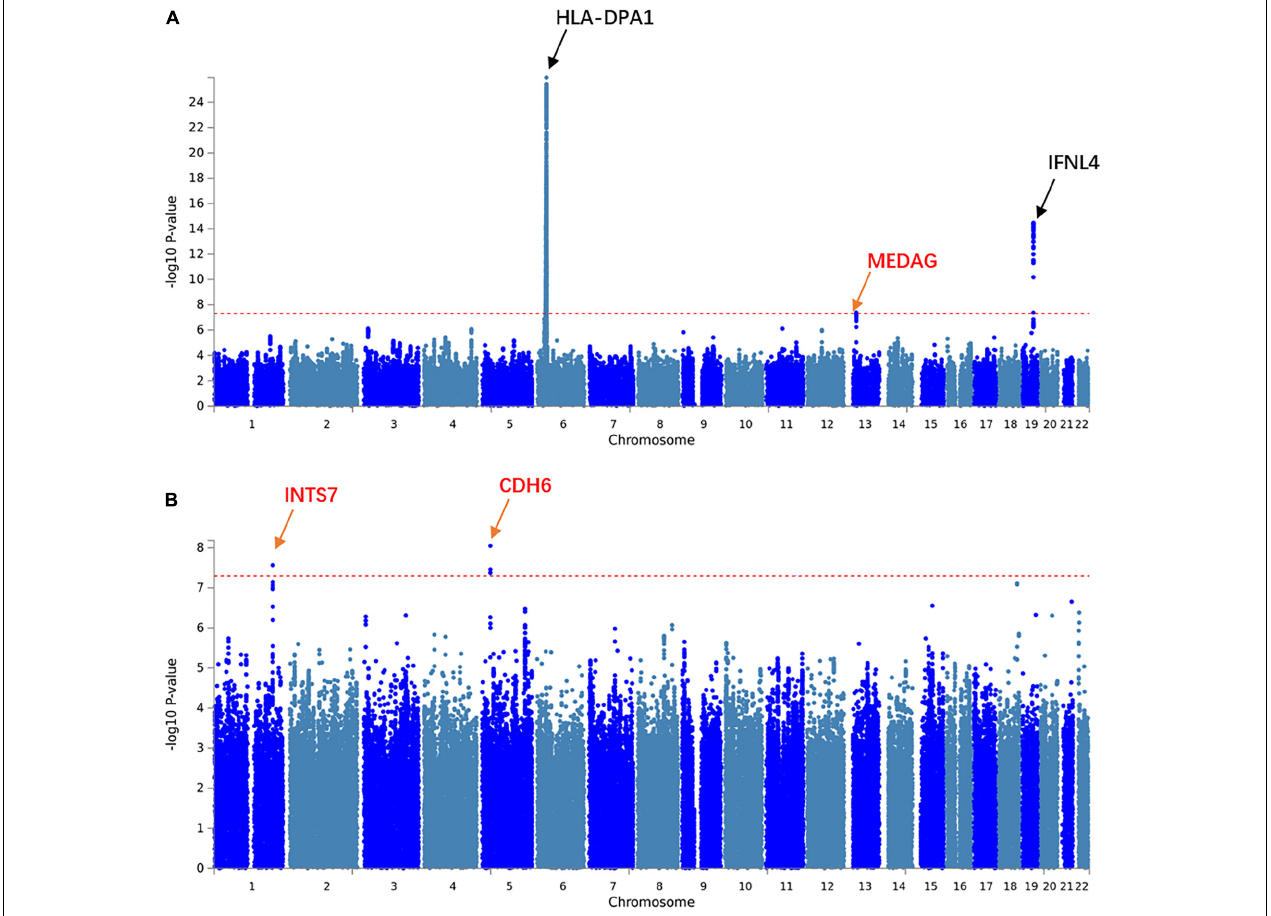
FIGURE 1 | Manhattan plots showing the association statistics for hepatitis B virus (HBV)/hepatitis C virus (HCV) meta-analysis results in populations of Asian and European ancestries, respectively. (A) A meta-analysis on genome-wide association study (GWAS) summary statistics in the database of the Japanese ENcyclopedia of GEnetic associations by Riken. (B) A meta-analysis on GWAS summary statistics in the Pan UK Biobank. The genomic coordination of single-nucleotide polymorphisms (SNPs) is indicated on the X -axis, and the -log10 of P -value per SNP in meta-analysis is indicated on the Y -axis. The horizontal red line represents the genome-wide significance threshold P -value = 5 × 10 − 8 . The closest genes to the previously reported loci are shown in black, and those closest to the novel loci are shown in